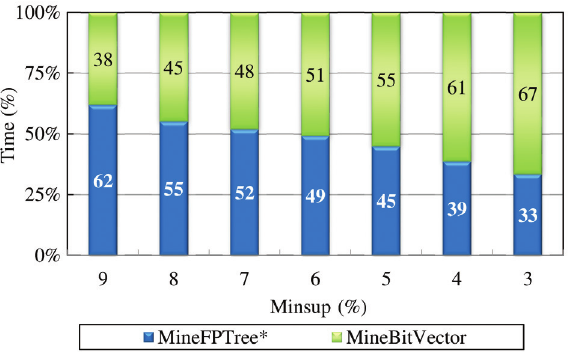
Figure 15. Time Distribution of Two Mining Strategies in DFEM for Accidents Dataset with Different minsup Input